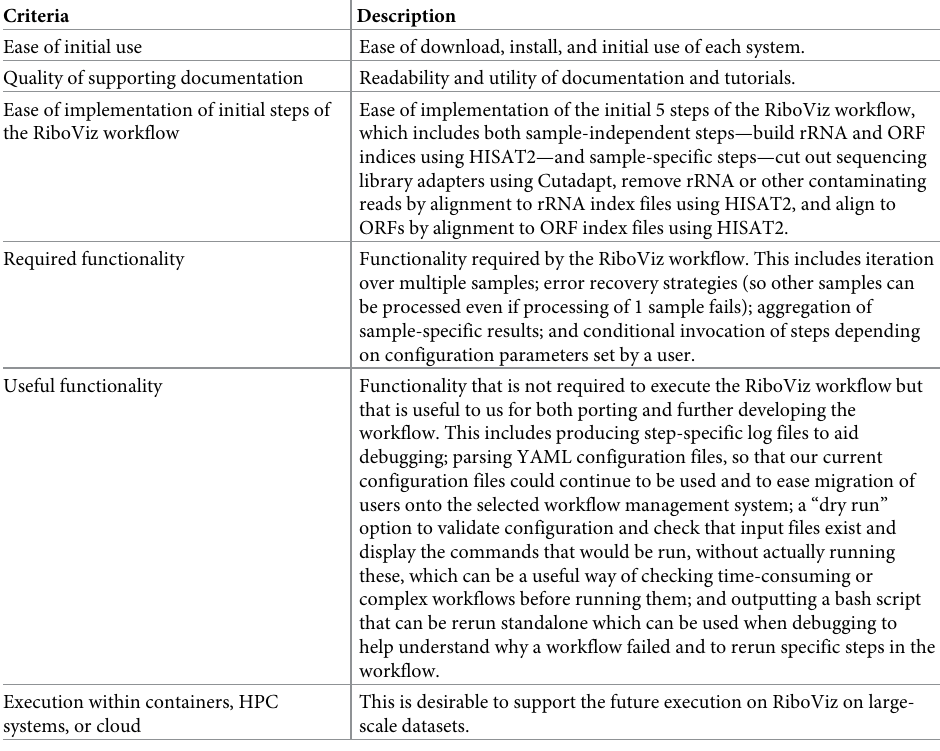
Table 4. Evaluation